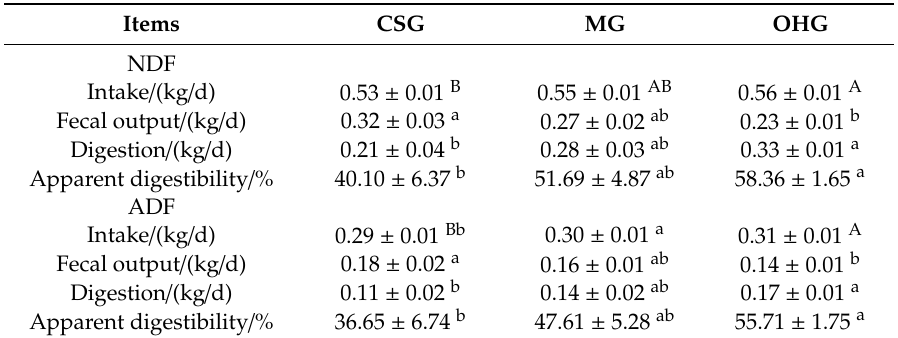
Table 4. E ff ects of dried oat hay content in diet on neutral detergent fiber (NDF) and acid detergent fiber (ADF) apparent digestibility of